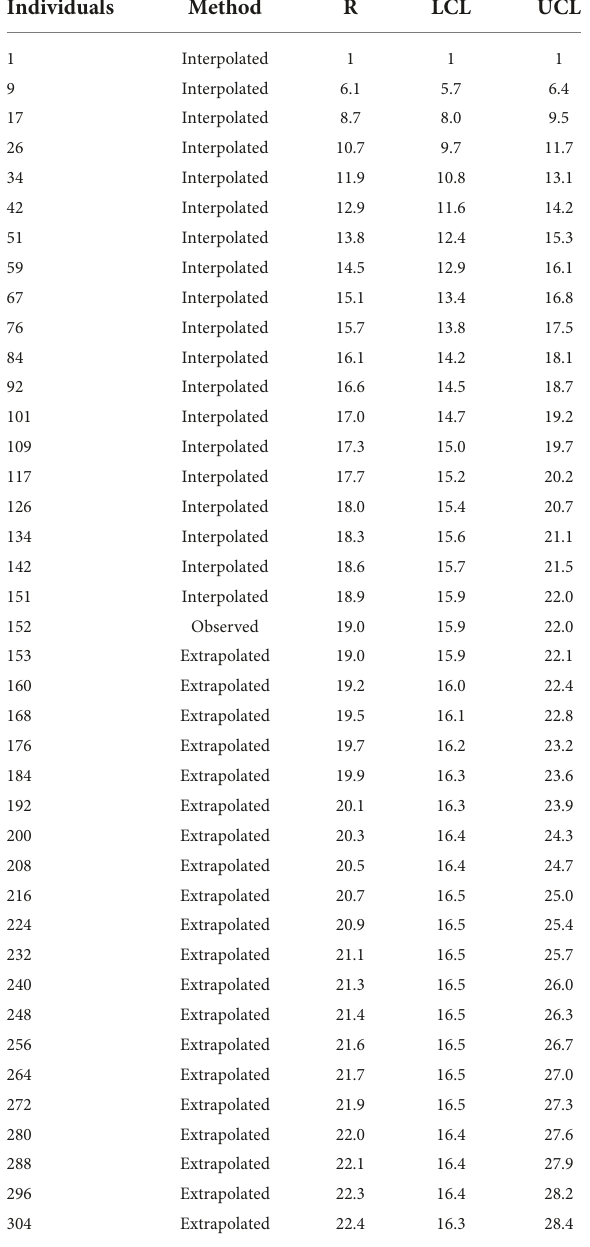
TABLE 3 Estimated richness of bird species that forage on Guamúchil across Zacualpan, Colima, Mexico. Individuals